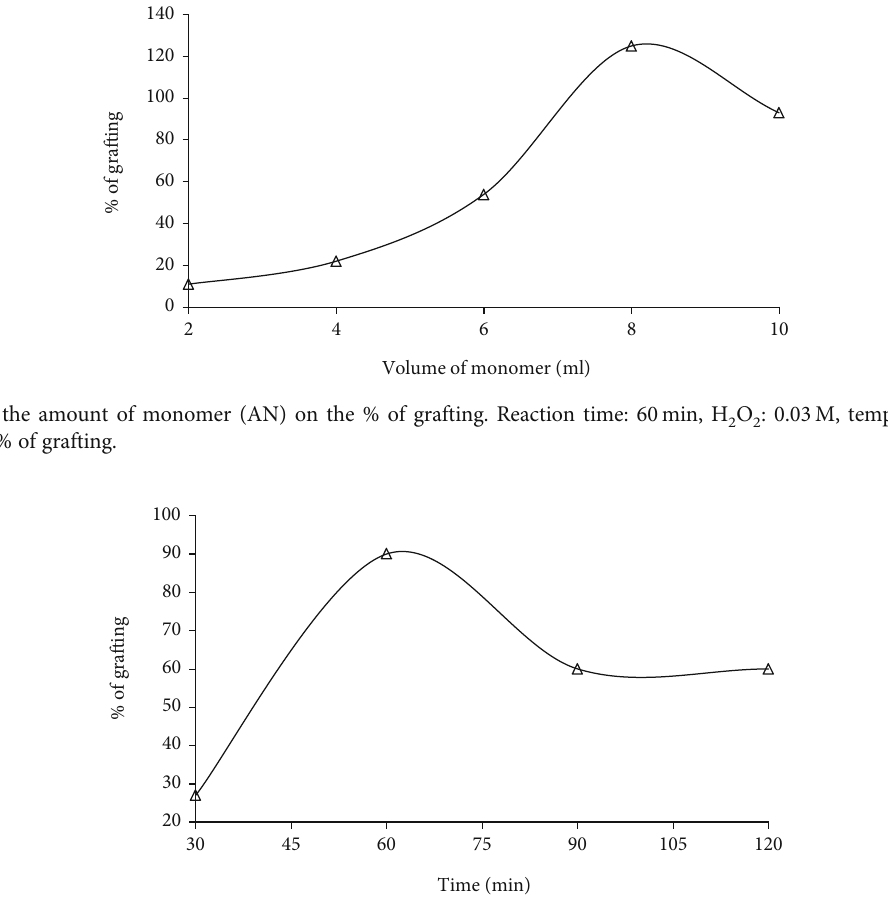
O : 0.03 M, temperature: 75 ° C, Fe +2 : 0.3mmol, and ( Δ ): % 2 2